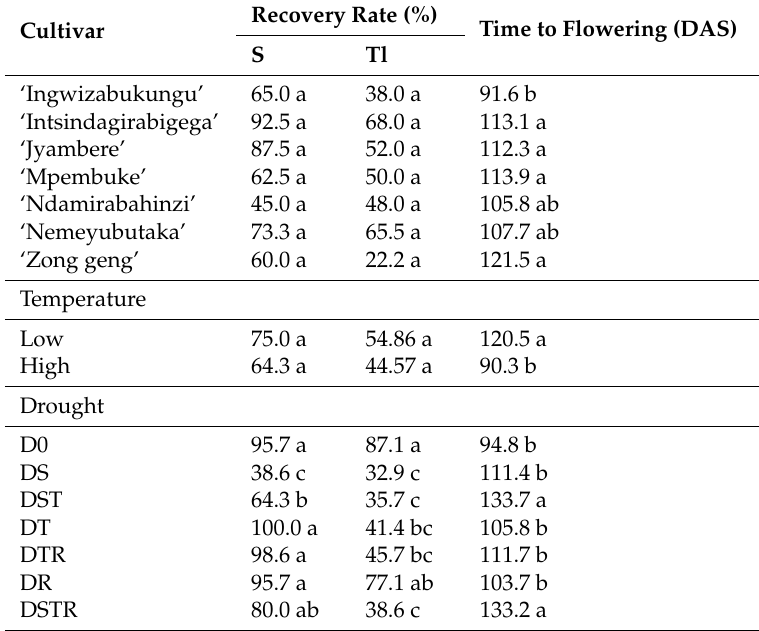
Table 3. Recovery rate at the seeding (S) and tillering (Tl) stages and time to flowering.